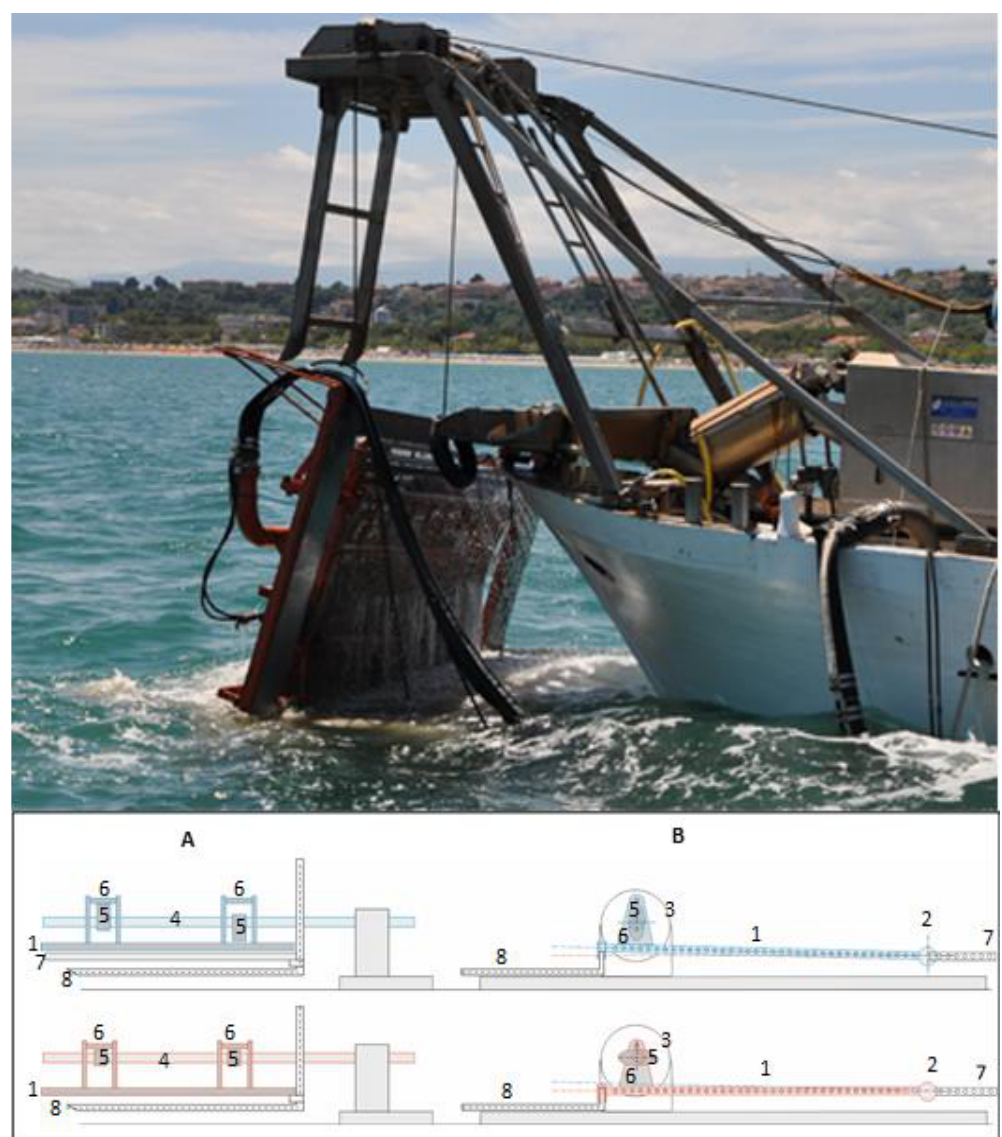
Figure 3. In the upper side a picture of the vibrating hydraulic dredge on the ship. Below a detail of the oscillating system of the prototype: rear view (A) and side view (B). (1) oscillating section of the dredge; (2) hinge (center of rotation) of the oscillating section; (3) hydraulic motor; (4) camshaft operated by the hydraulic motor; (5) cam; (6) frame with a pin, integrated in the oscillating section, for the lifting during cams rotation; (7) fixed section or the dredge bottom; (8) clam storage basket on the rear end. Top: oscillating section lifted in its highest position by the push of cams on the pins — Bottom: the cams do not touch the pins and the rear border of the oscillating section rests on the front wall of the basket.